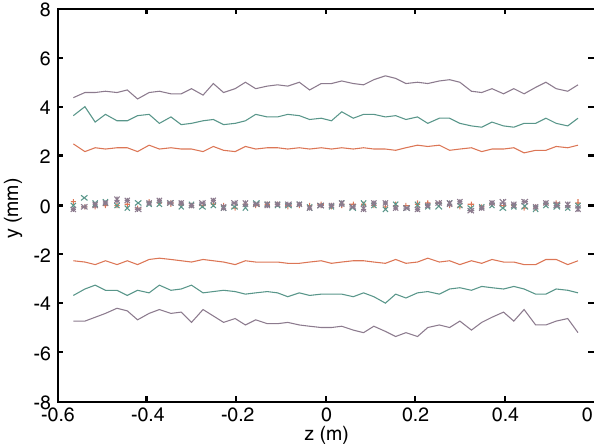
FIG. 48. (Color) Vertical emittance growth for LHC example parameters as a function of time simulated by HEADTAIL (green curve) and by the discrete version of QUICKPIC (red curve) with a single electron-beam interaction per